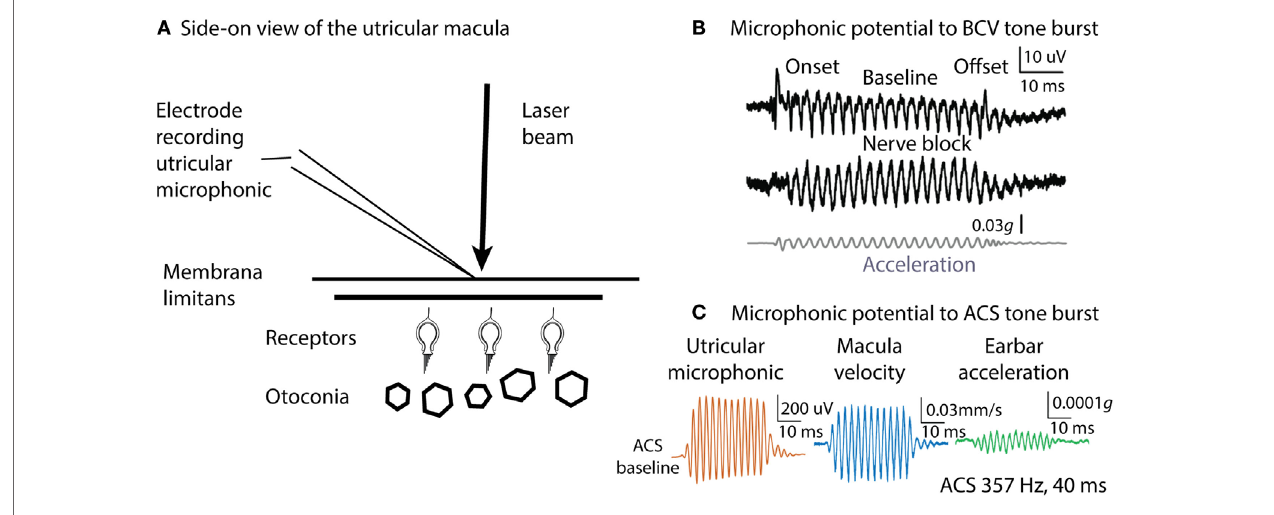
FigURe 5 | Microphonic recording and laser Doppler measurement of macula movement, showing the relation between the vestibular microphonic and the velocity of macula movement during bone-conducted vibration (BCV) or air-conducted sound (ACS) stimulation. A microelectrode on the surface of the utricular macula (A) records a microphonic potential from the utricular receptors in response to BCV (B) or to ACS (C) . There is no contribution from the cochlea since it has been completely ablated. (B) Vestibular microphonic responses to a BCV tone burst (40 ms, 400 Hz sinusoid) prior (top trace) and following (middle trace) lignocaine application to the vestibule to block the vestibular nerve. The microphonic remains after lignocaine injection showing it is a receptor field potential. Bottom trace: the BCV stimulus; the linear acceleration as recorded by a triaxial linear accelerometer on the ear bar. (C) Laser Doppler vibrometry. A laser beam is projected onto a reflective glass bead on the macula and the Doppler shift of the wavelength of the reflected beam shows the velocity of macula movement during BCV or ACS stimulation. Panel (C) shows the simultaneous measurement of vestibular microphonic and macula velocity. (B) Reprinted from Pastras et al. (57), © 2017, with permission from Elsevier. Panel (C) is from Pastras et al.